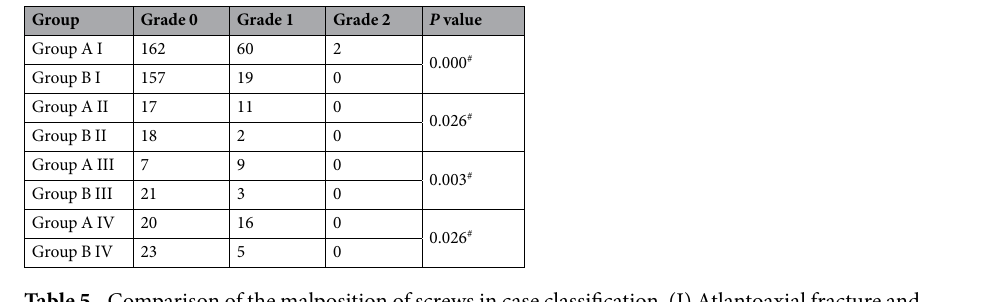
Table 5. Comparison of the malposition of screws in case classification. (I) Atlantoaxial fracture and dislocation (II) Congenital odontoid nonunion. (III) Atlantoaxial Instability due rheumatoid arthritis. (IV) Other causes of atlantoaxial instability. # P < 0.05 compared to the data of Group A.